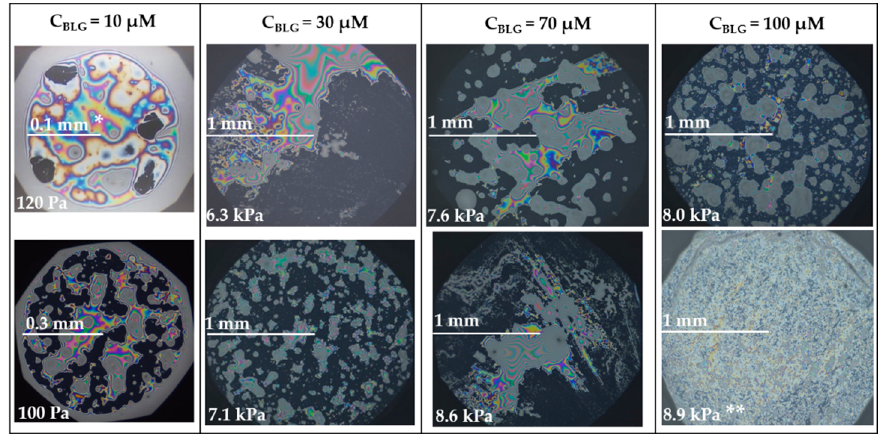
Figure 5. Foam Newton black films (NBFs) at different C BLG (pH 5, C buff = 10 mM) formed slowly by protocol ‘A’; the photos were taken at moments close to film rupture. * This film was obtained in a glass tube cell (see Figure S5 in the Supplementary Materials); ** This film was formed rapidly by protocol ‘B’ (see Figure 6 c ).